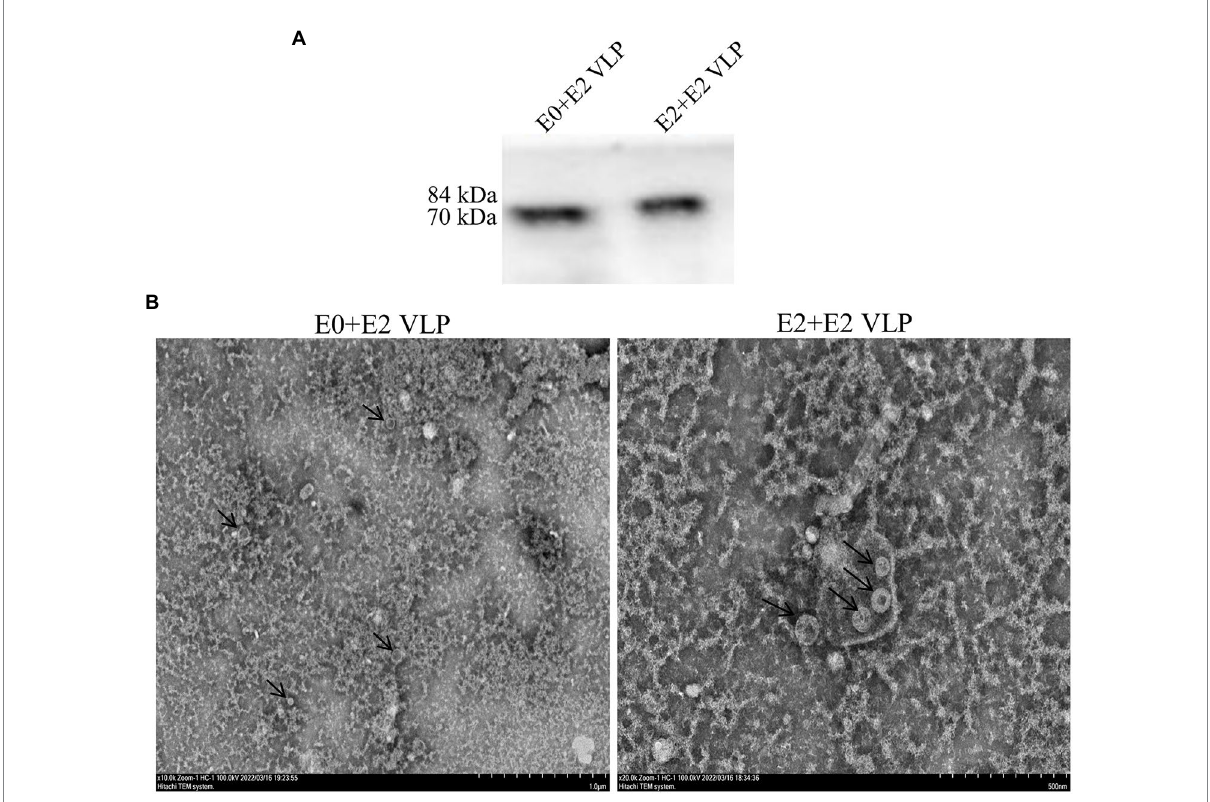
FIGURE 2 Purification and structure of BVDV-VLPs. (A) Sucrose purified VLPs were examined by western blotting. His-tag antibody (dilution, 1:2,000) as the primary antibody, and HRP-conjugated goat anti-mouse IgG (dilution, 1:5,000) as the secondary antibody. (B) TEM of negatively stained BVDV VLPs. HT7700 was used for observation of VLPs. VLPs were spherical in morphology, with diameters of about 50–100